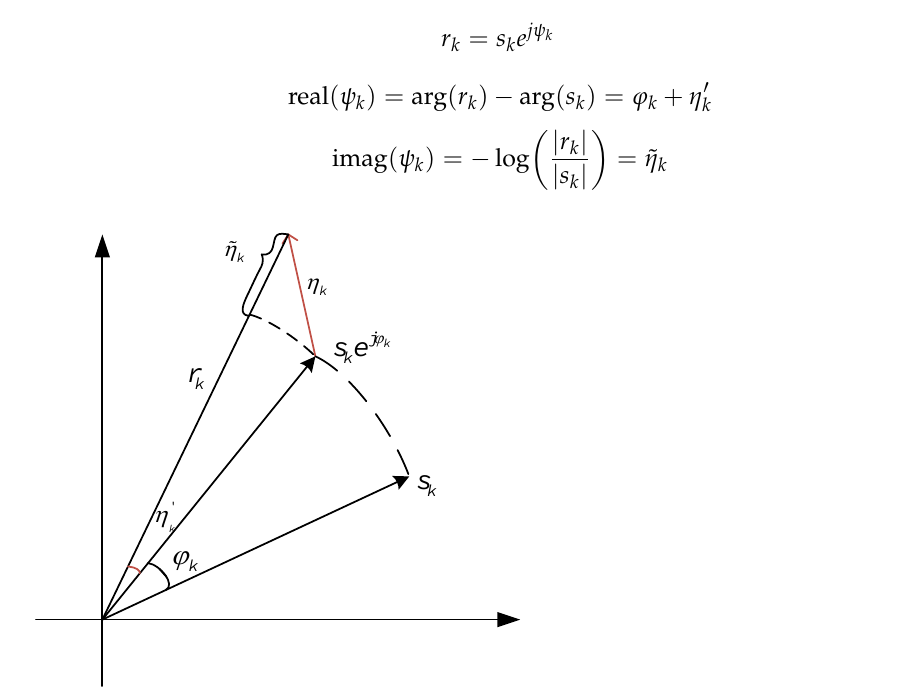
Figure 2. Input signal model to CPE